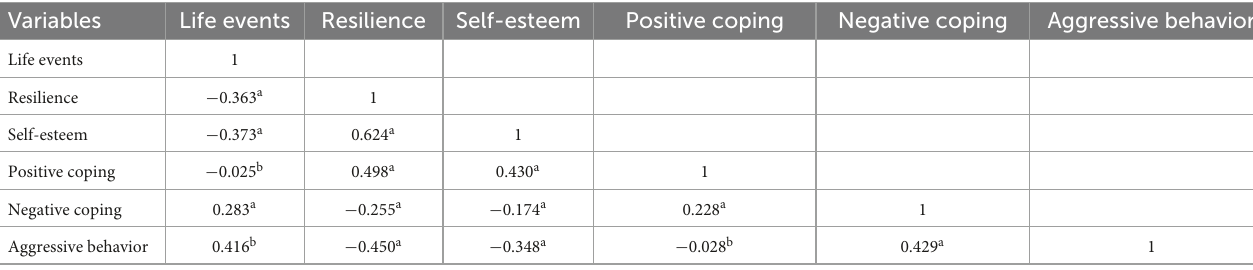
TABLE 3 Correlations among the measured variables ( n = 751).